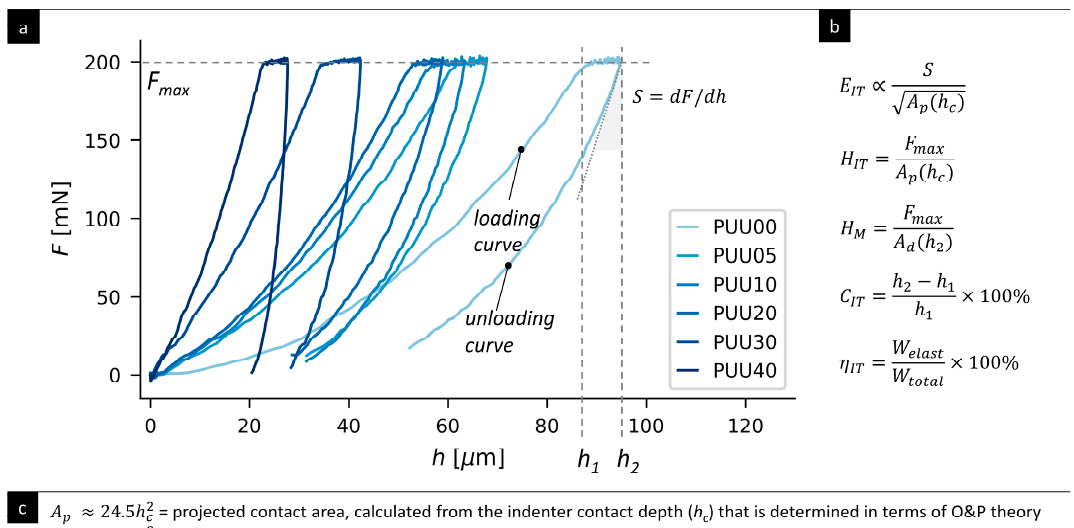
Figure 3. Representative F - h curves from microindentation hardness testing for all investigated PUU/nanosilica composites that contained 0, 5, 10, 20, 30, and 40% of the SiO 2 , and a brief description of principle of MHI measurements: ( a ) micromechanical properties were deduced from the experi- mental F - h curves, ( F = indenter loading force, h = indenter penetration depth) by means of the for- mulas from ( b ) and the relationships from ( c ) containing experimental parameters, such as maxi- mum loading force ( F max ), slope at the beginning of the unloading curve ( S ), penetration depths at the beginning and end of the maximal load ( h 1 and h 2 ), and areas under the loading and unloading curve ( W elast and W total ). The additional parameter, contact depth ( h c ), was calculated in terms of the Oliver & Pharr theory and employed in the calculation of E IT and H IT , as described in our previous work [2,3]. The figure (a) shows real, representative F - h curves of PUU/nanosilica composites that